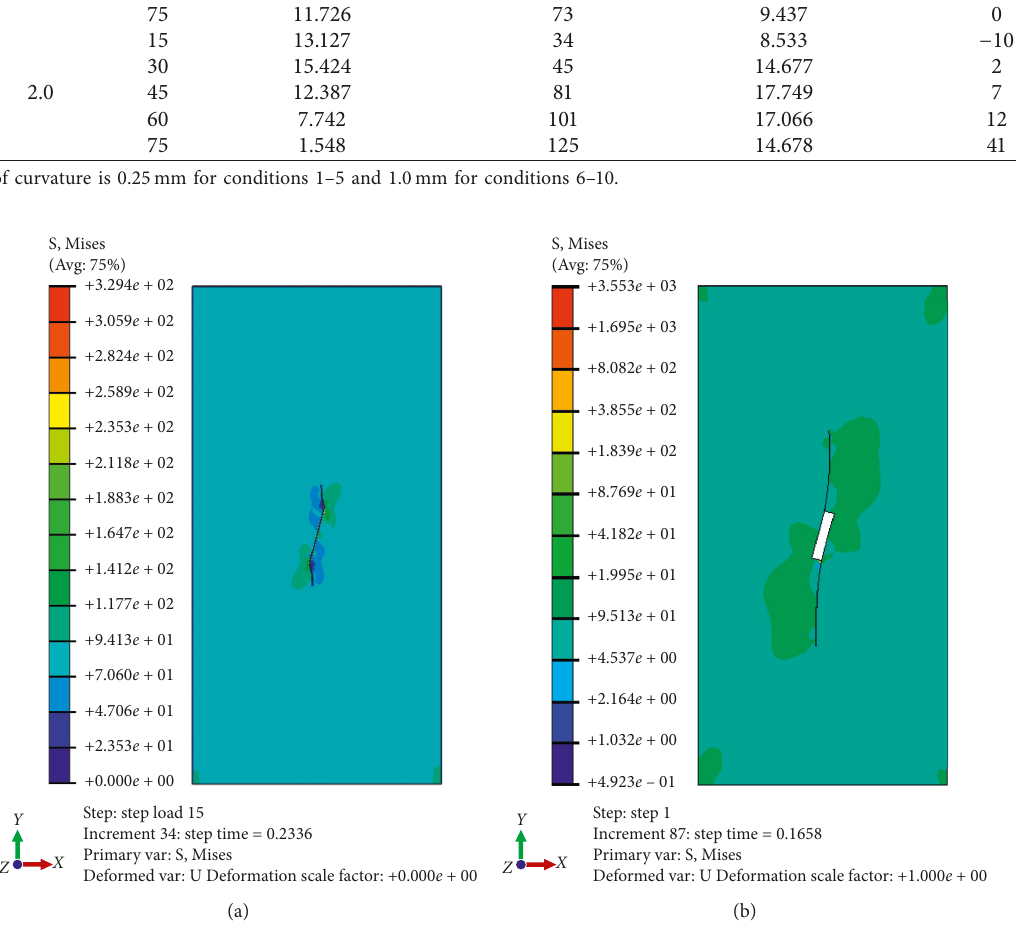
Figure 6: Numerical simulation of fracture propagation with β � 15 ° : (a) 0.5mm thick crack ( ρ � 0.25mm); (b) 2.0mm thick crack ( ρ � 1.0